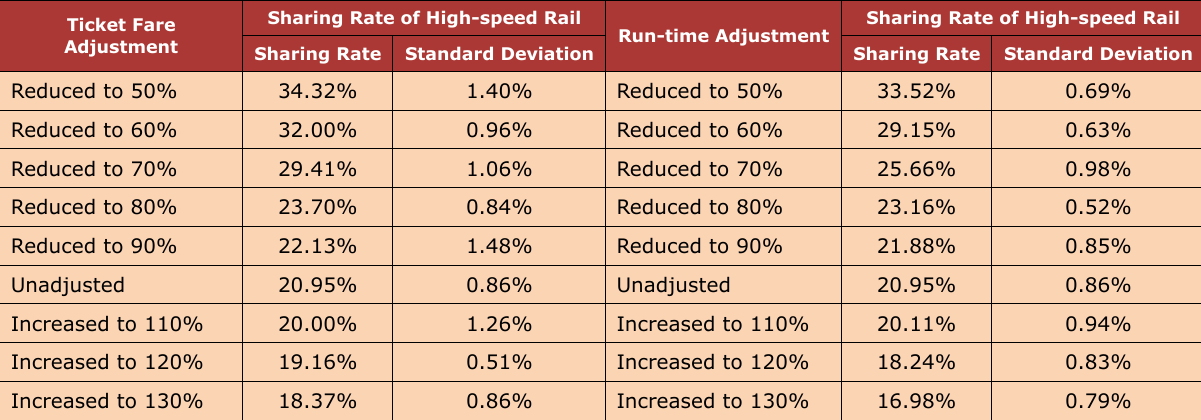
Table 1. The Influence of the Ticket Fare and Run-time Adjustment on the Passenger-sharing Ratio